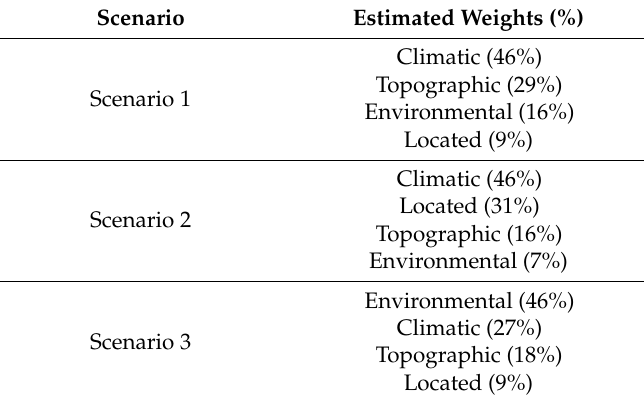
Table 6. Estimated Weighs for the Criteria of the Study.